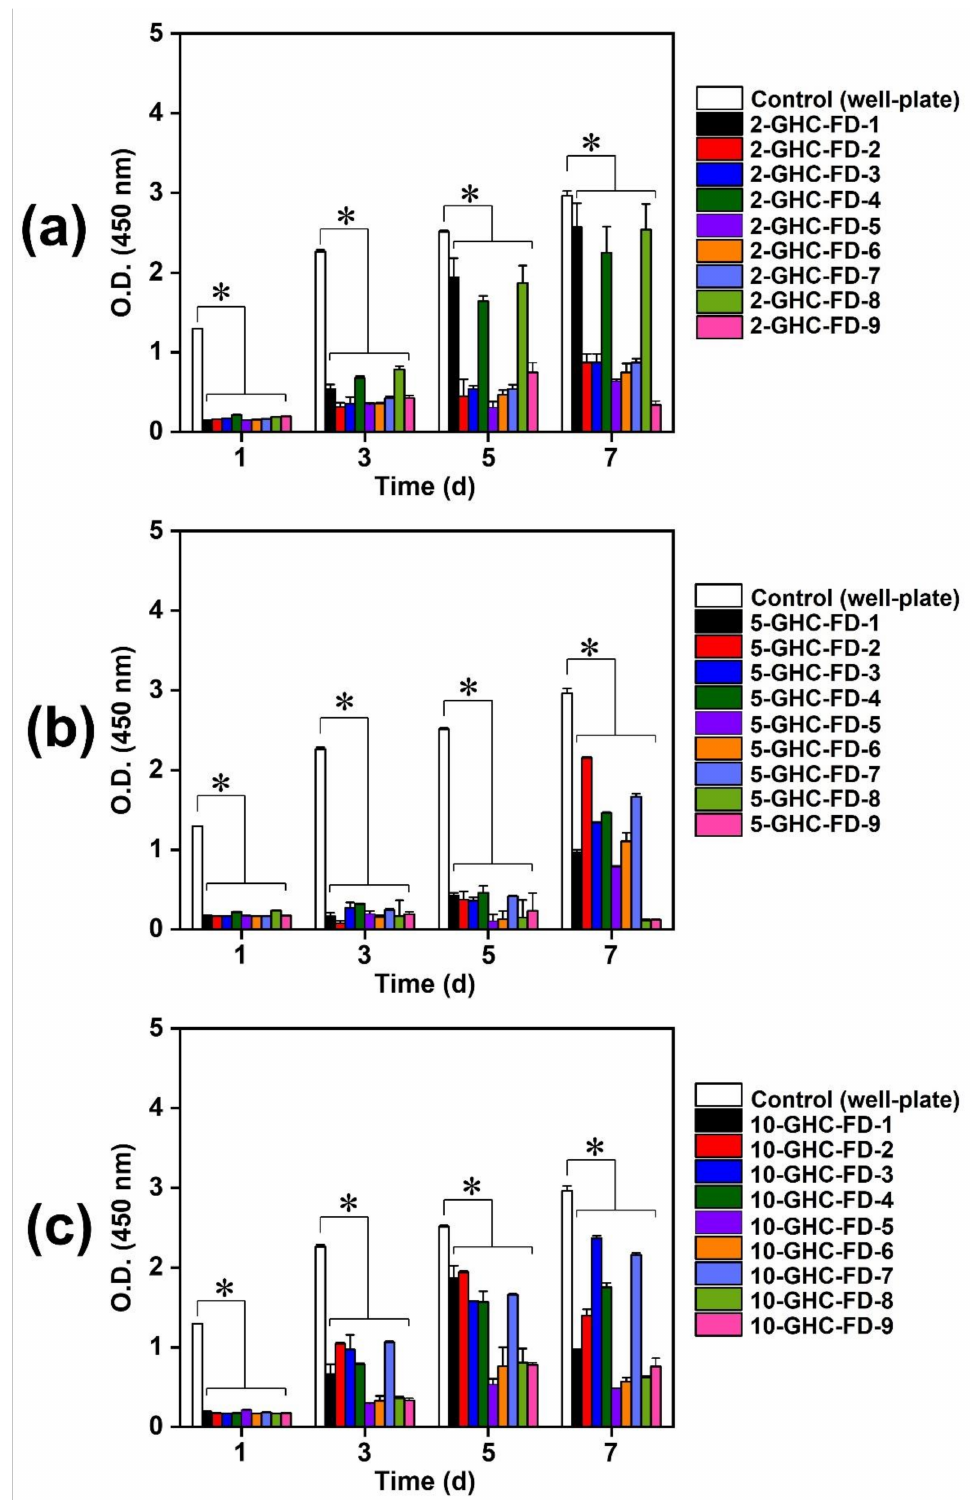
Figure 3. O.D. values of ( a ) 2-GHC-FD-1-9, ( b ) 5-GHC-FD-1-9, and ( c ) 10-GHC-FD-1-9 measured by CCK-8 assay at 450 nm. The test was performed for 1, 3, 5, and 7 days ( n = 5). As a control, O.D. of cells cultured on well-plate was used. The statistical significance was indicated by an asterisk (*) for p < 0.05. The FD samples were compared to control (well-plate). At ( a – c ) graphs, the FD samples had significant differences as compared to control (well plate). The type of this result is involved in continuous